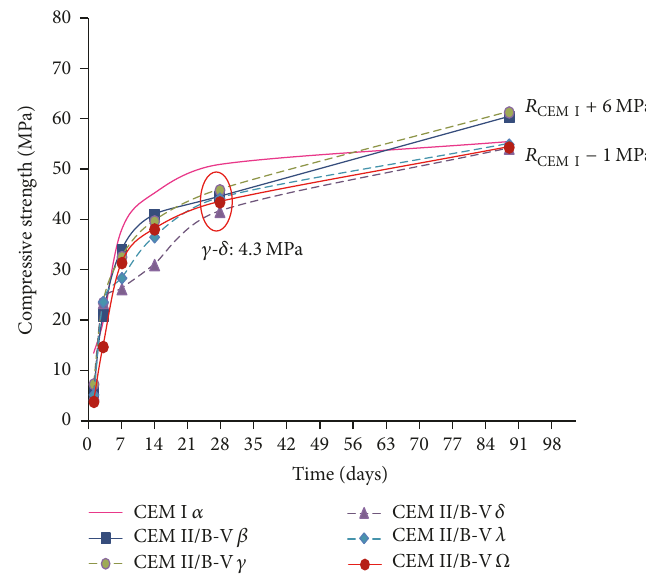
Figure 3: CEM II/B-V compressive strength (MPa).